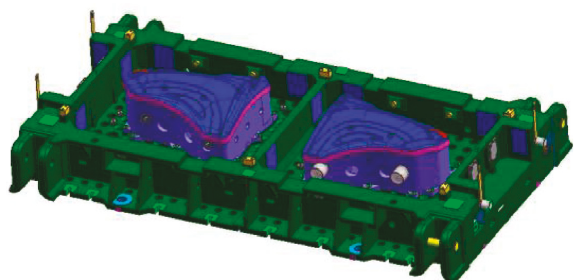
Figure 2: 3D model of punch.